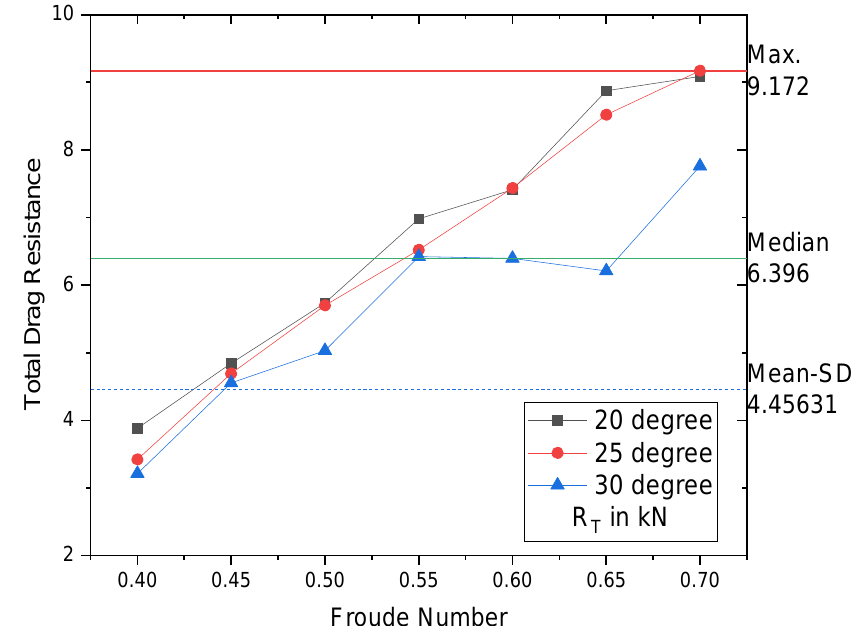
Figure 9. Total drag vs. deadrise angle variation of the initial design compared to Wipeline ® 13000 design.